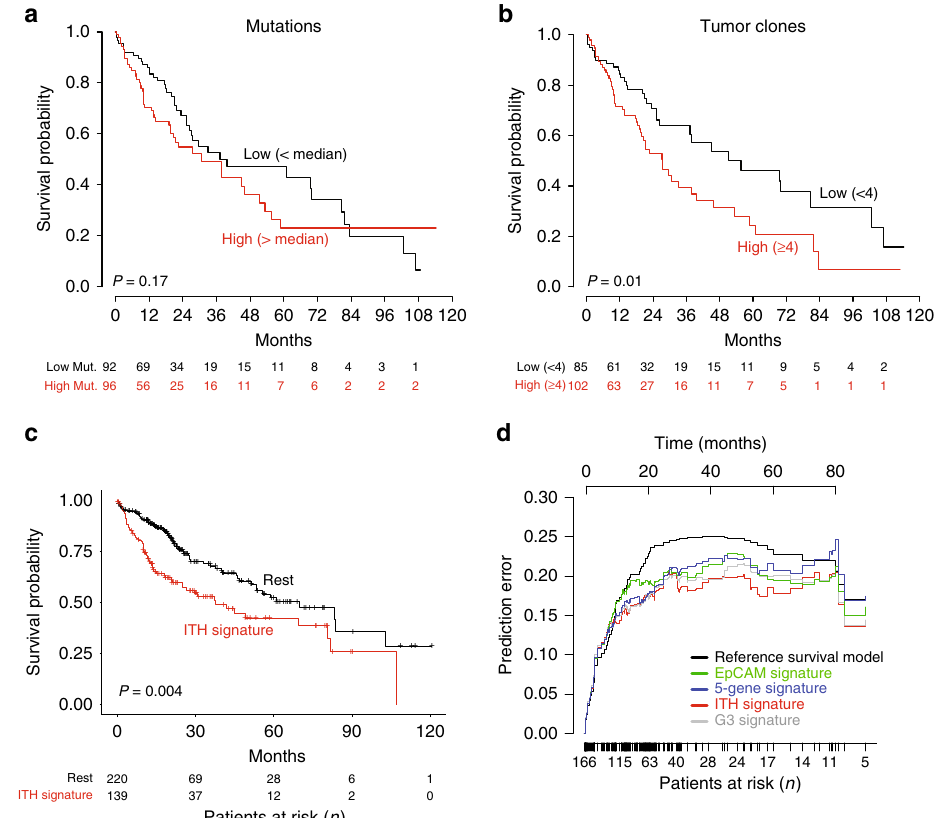
Fig. 5 Survival analyses of ITH models in TCGA-HCC. a Kaplan-Meier curves with HCC DNA mutations and b DNA-based clonality estimates. c Kaplan- Meier curve for overall survival in the TCGA dataset after patients are classi fi ed based on the ITH signature. d Prediction error curves of competing parametric Cox proportional hazard models depicting time dependent Brier score for models built from principal components of the G3, EpCAM, 5-gene, and ITH signatures. Survival analysis was done using the Kaplan-Meier (log-rank)